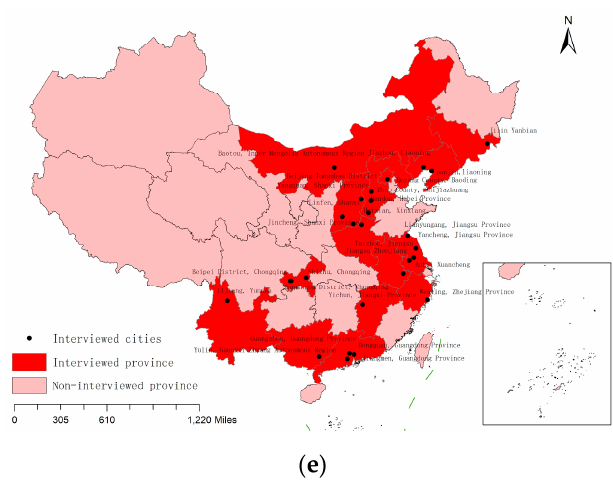
Figure 1. The geographical distribution of China’s EPI cities from 2014 to 2018. ( a ) The distribution of the EPI cities in 2014. ( b ) The distribution of the EPI cities in 2015. ( c ) The distribution of EPI cities in 2016. ( d ) The distribution of EPI cities in 2017. ( e ) The distribution of EPI cities in 2018. Source: This data was collated by the authors themselves and the sources are as follows: http://www.gov.cn/xinwen/2019-01/07/content_5355429.htm; http://www.gov.cn/xinwen/2016-12/07/content_5144822.htm (accessed on 30 January 2023).